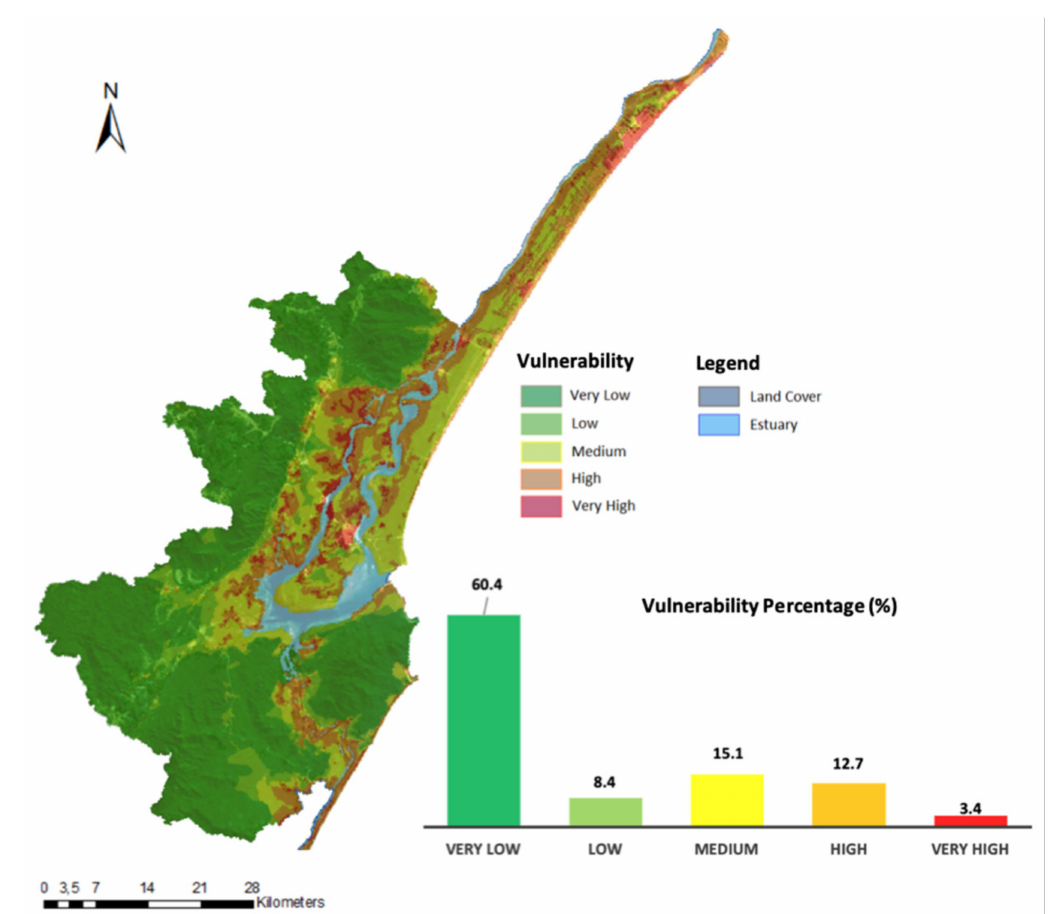
Figure 3. Erosion Global vulnerability levels of the Canan é ia-Iguape system (24 ◦ 50 (cid:48) , 25 ◦ 40 (cid:48) S; 47 ◦ 20 (cid:48) , 48 ◦ 20 (cid:48) W). Vulnerability Areas (Vulnerability percentage associated with each area as well as its corresponding percentage) are also